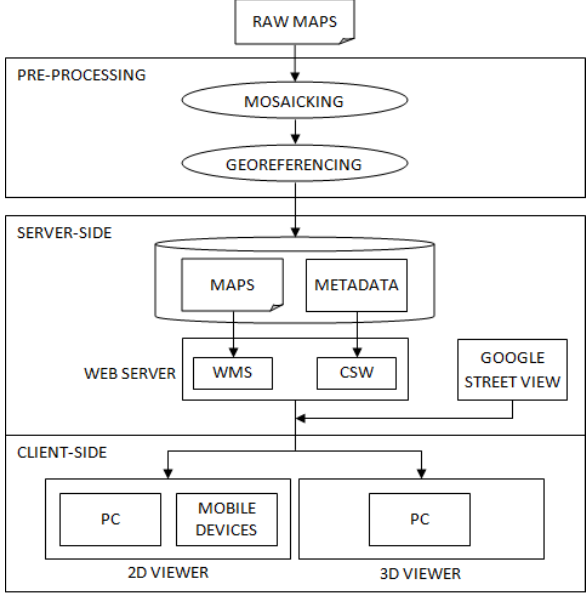
Figure 1. Architecture of the